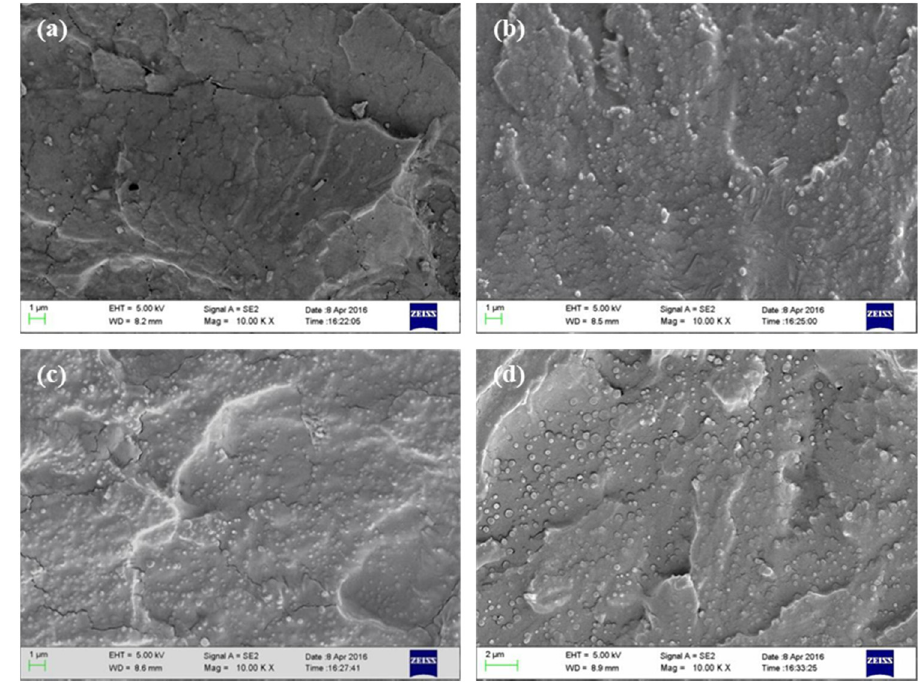
Figure 3: Fracture surfaces of ( a ) PVA/PLA ( PVA 95 wt% ) , ( b ) PVA/PLA ( PVA 90 wt% ) , ( c ) PVA/PLA ( PVA 80 wt% ) , and ( d ) PVA/PLA ( PVA 70 wt% ) .